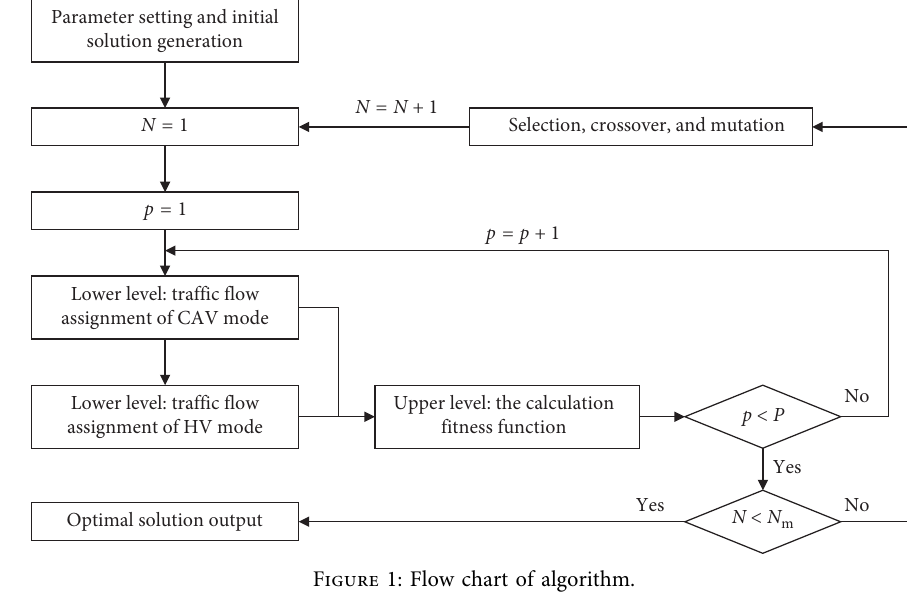
Figure 1: Flow chart of algorithm.